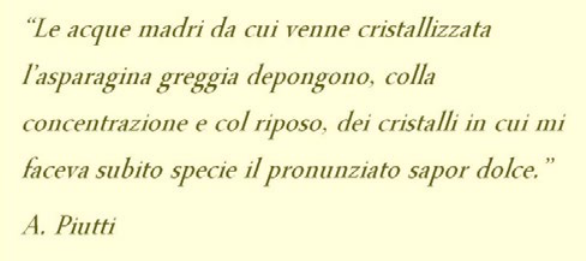
Figure 3. The words of Piutti about the first discover of sweet asparagine: “ From the mother liquor from which the asparagine was crystallized, some crystals formed whose pronounced sweet taste I immediately caught ” 15 .